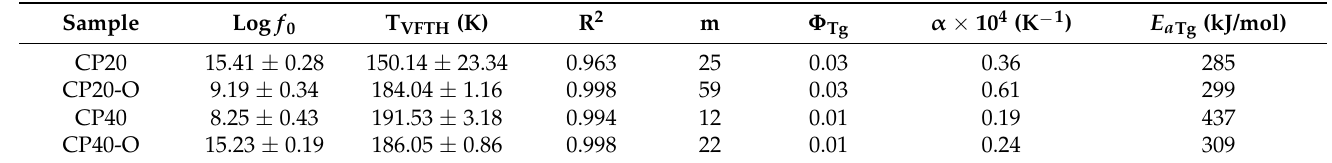
Table 4. Parameters for the VFTH model and derived parameters for the study of the α Tg relaxation of the modified oriented and unoriented copolymers.